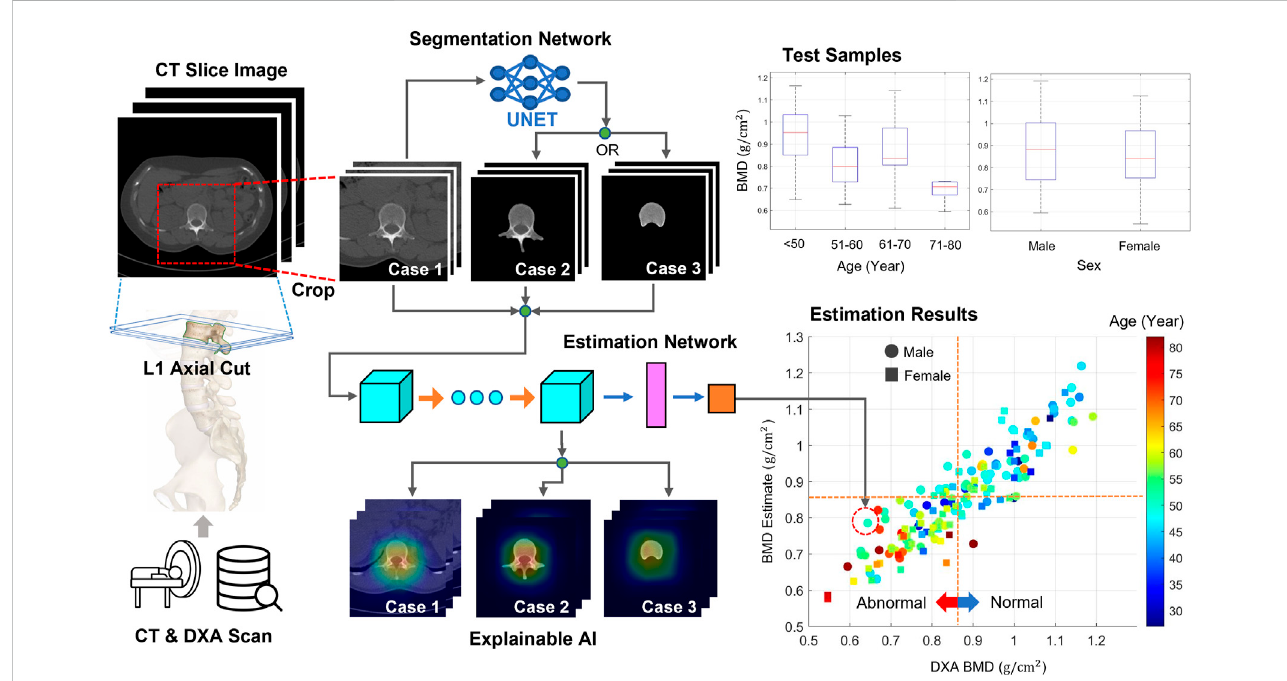
FIGURE 1 Work fl ow of this study. From the CT axial images, two image sets were generated. The fi rst set included images cropped around lumbar vertebrae from originalimages.Thesecondsetincludedimages highlighting onlythebonebodyusingasegmentationtechnique.Theneuralnetworkwastrainedandtested using either image set for predicting BMDs. DXA BMDs were used as references for supervised learning. Bone diseases, such as osteoporosis and osteopenia, were screened using a T-score converted from every BMD. In addition, the attention map was obtained using XAI techniques to examine the important regions for the BMD prediction.